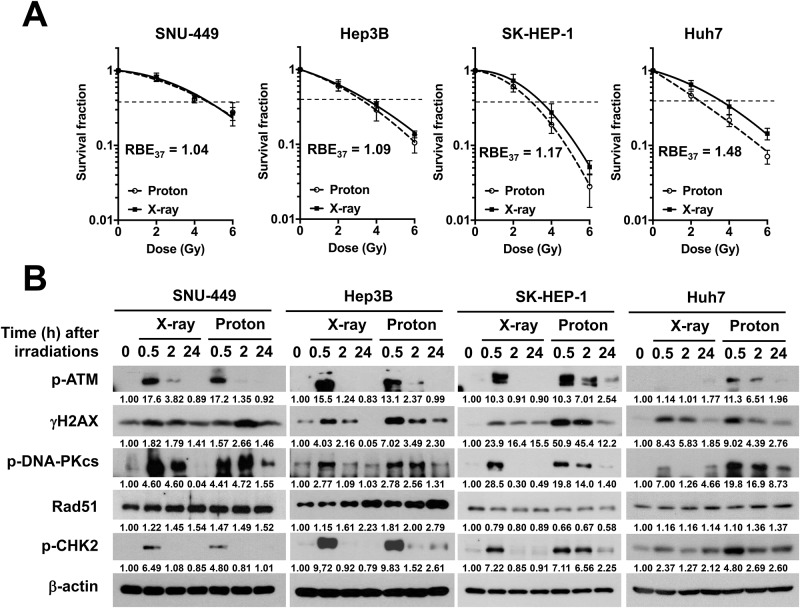
Cellular responses to X-rays and protons differ in HCC cell lines.(A) Dose-response curves of SNU-449, Hep3B, SK-HEP-1 and Huh7 against X-rays (solid curves) or protons (dashed curves). RBE37 of four HCC cell lines were compared (dotted lines). Data represent mean ± SD from three independent experiments and were fit in Graphpad Prism using a linear-quadratic model. (B) Time-dependent cellular responses to X-rays and protons in HCC cells. Each cell line was irradiated with 6 Gy of X-rays or protons and were harvested at the indicated times. Western blot analysis shows four HCC cell lines differs in DNA damage response signaling against X-rays or protons. β-actin was used as a loading control. p-ATM: phospho-ATM(S1981); γH2AX: phosphor-H2AX(Ser139); p-DNA-PKcs: phosphor-DNA-PKcs(S2016); p-CHK2: phospho-CHK2 (Thr68). Relative band intensity was quantified by densitometry using imageJ and the results normalized to β-actin are displayed under each blot.